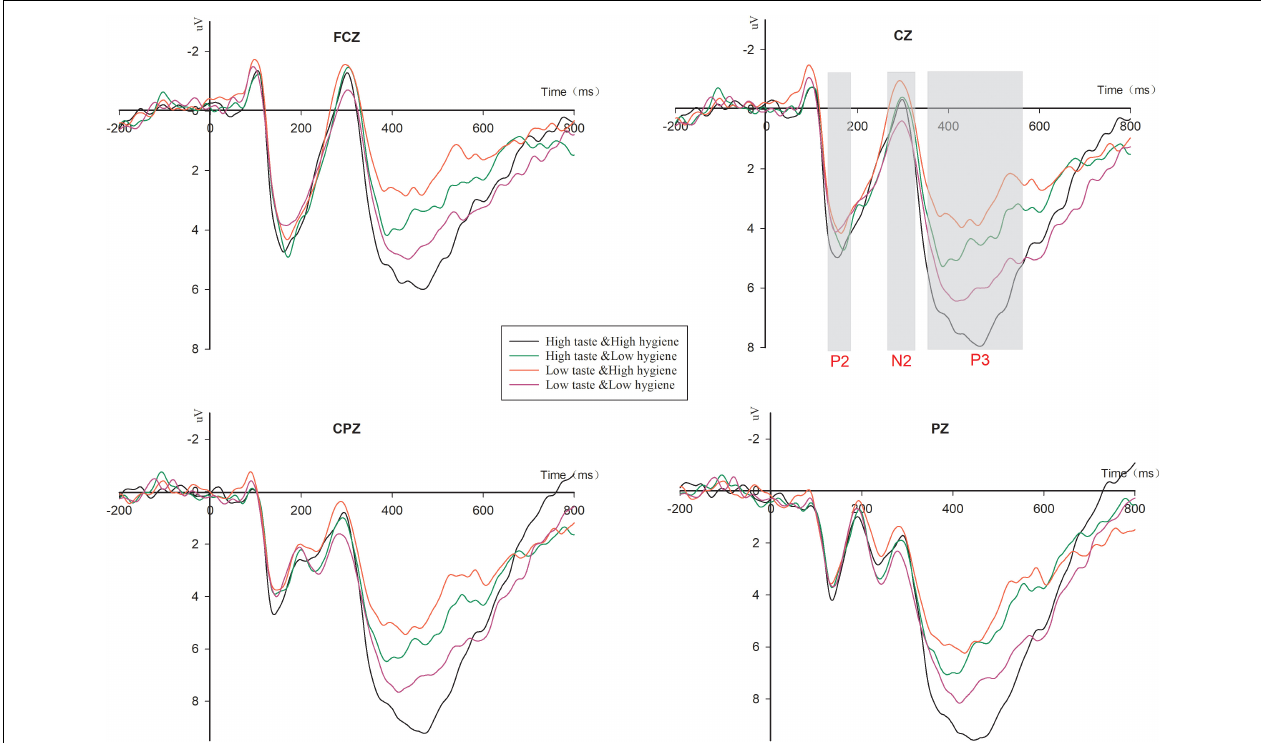
FIGURE 5 | Event-related potential (ERP) results in Study 2. Grand-average ERP waveforms of the frontal, fronto-central, and central regions recorded from the FCz, Cz, CPz, and Pz